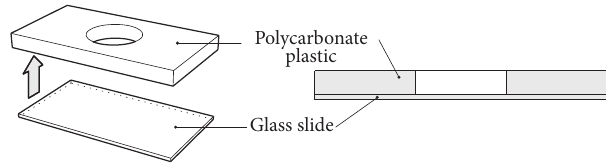
Figure 1: Diagrammatic representation of the glass-slide